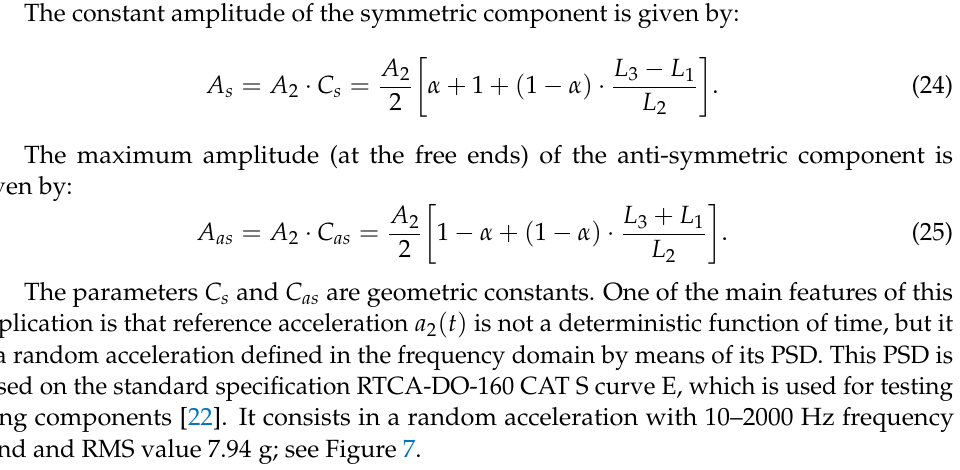
Figure 6. Components of acceleration amplitude: ( a ) symmetric; ( b ) anti-symmetric.